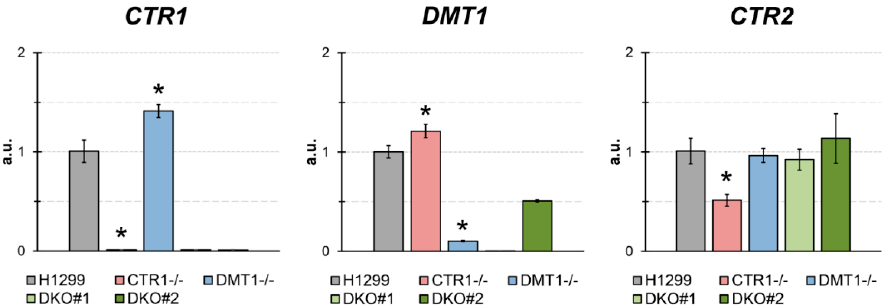
Figure 1. The estimates of expression of CTR1, DMT1, and CTR2 by qRT-PCR in parental H1299 cells, in one clone KO for CTR1 (clone 45), one clone KO for DMT1 (clone 31), clone CTR1 − / − , DMT1 +/ − (DKO2), and clone CTR1 − / − , DMT1 − / − (DKO1). Y-axis: mRNA fold over actin.